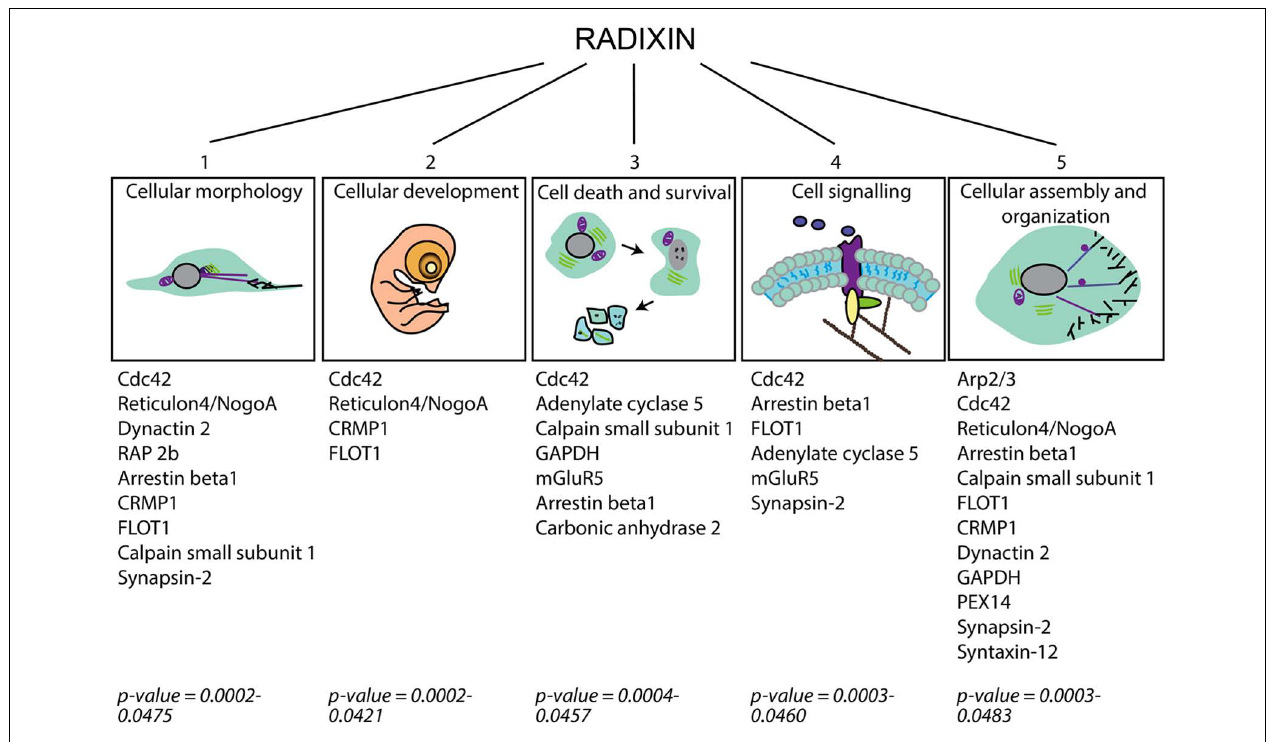
FIGURE 7 | Schematic figure categorizing cellular functions affected in the SVZ under radixin inhibition according to IPA analysis of the altered proteins as detected by proteome analysis. Proteins allocated to each cellular function group are presented and the associated p -value for their enrichment in the group of altered